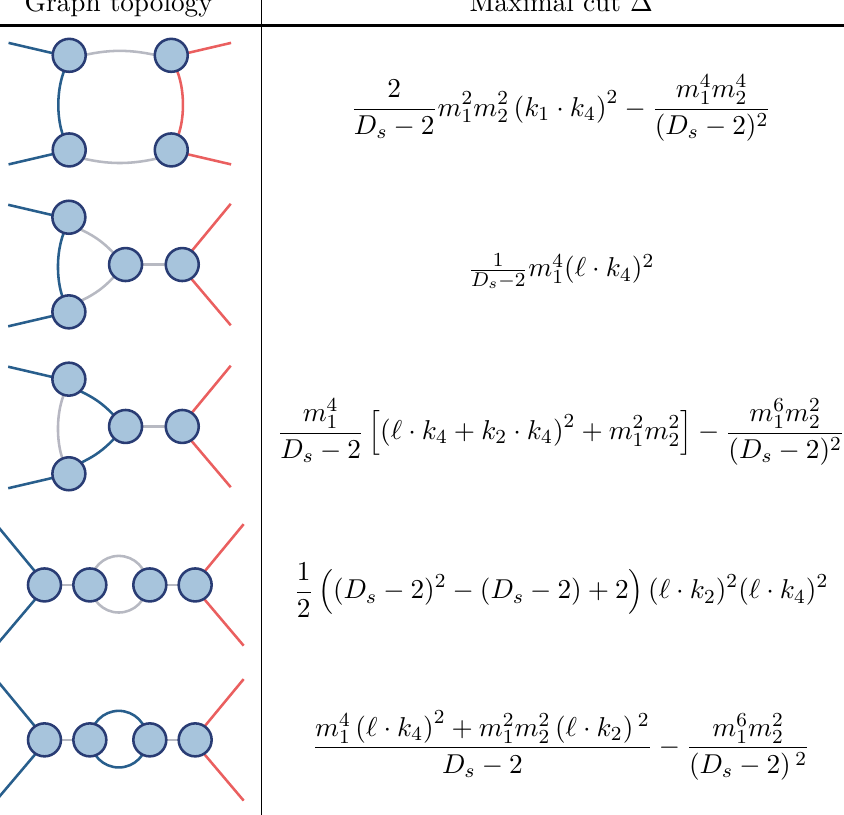
Table 4 . The ∆ contributions from the maximal cuts of the one-loop four-point amplitude, not including tadpole graphs. Blue blobs represent three point amplitudes, and exposed legs represent on-shell